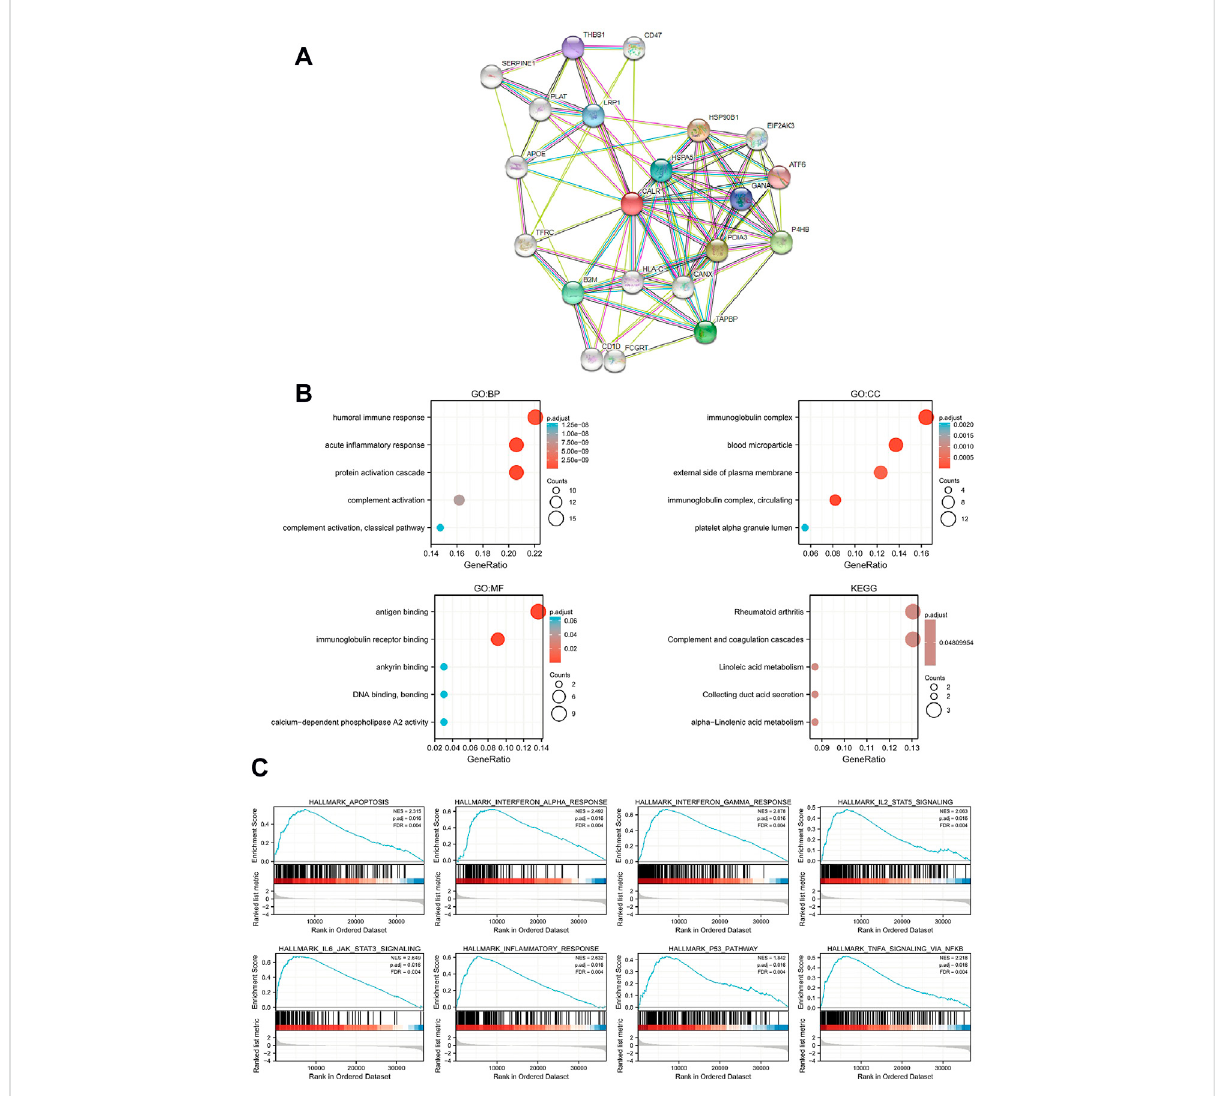
FIGURE 6 Functional and enrichment analysis of CALR in TCGA-KIRC. (A) PPI network of CALR and related proteins. (B) GO and KEGG analysis of CALR in KIRC. (C) Enrichment plots from